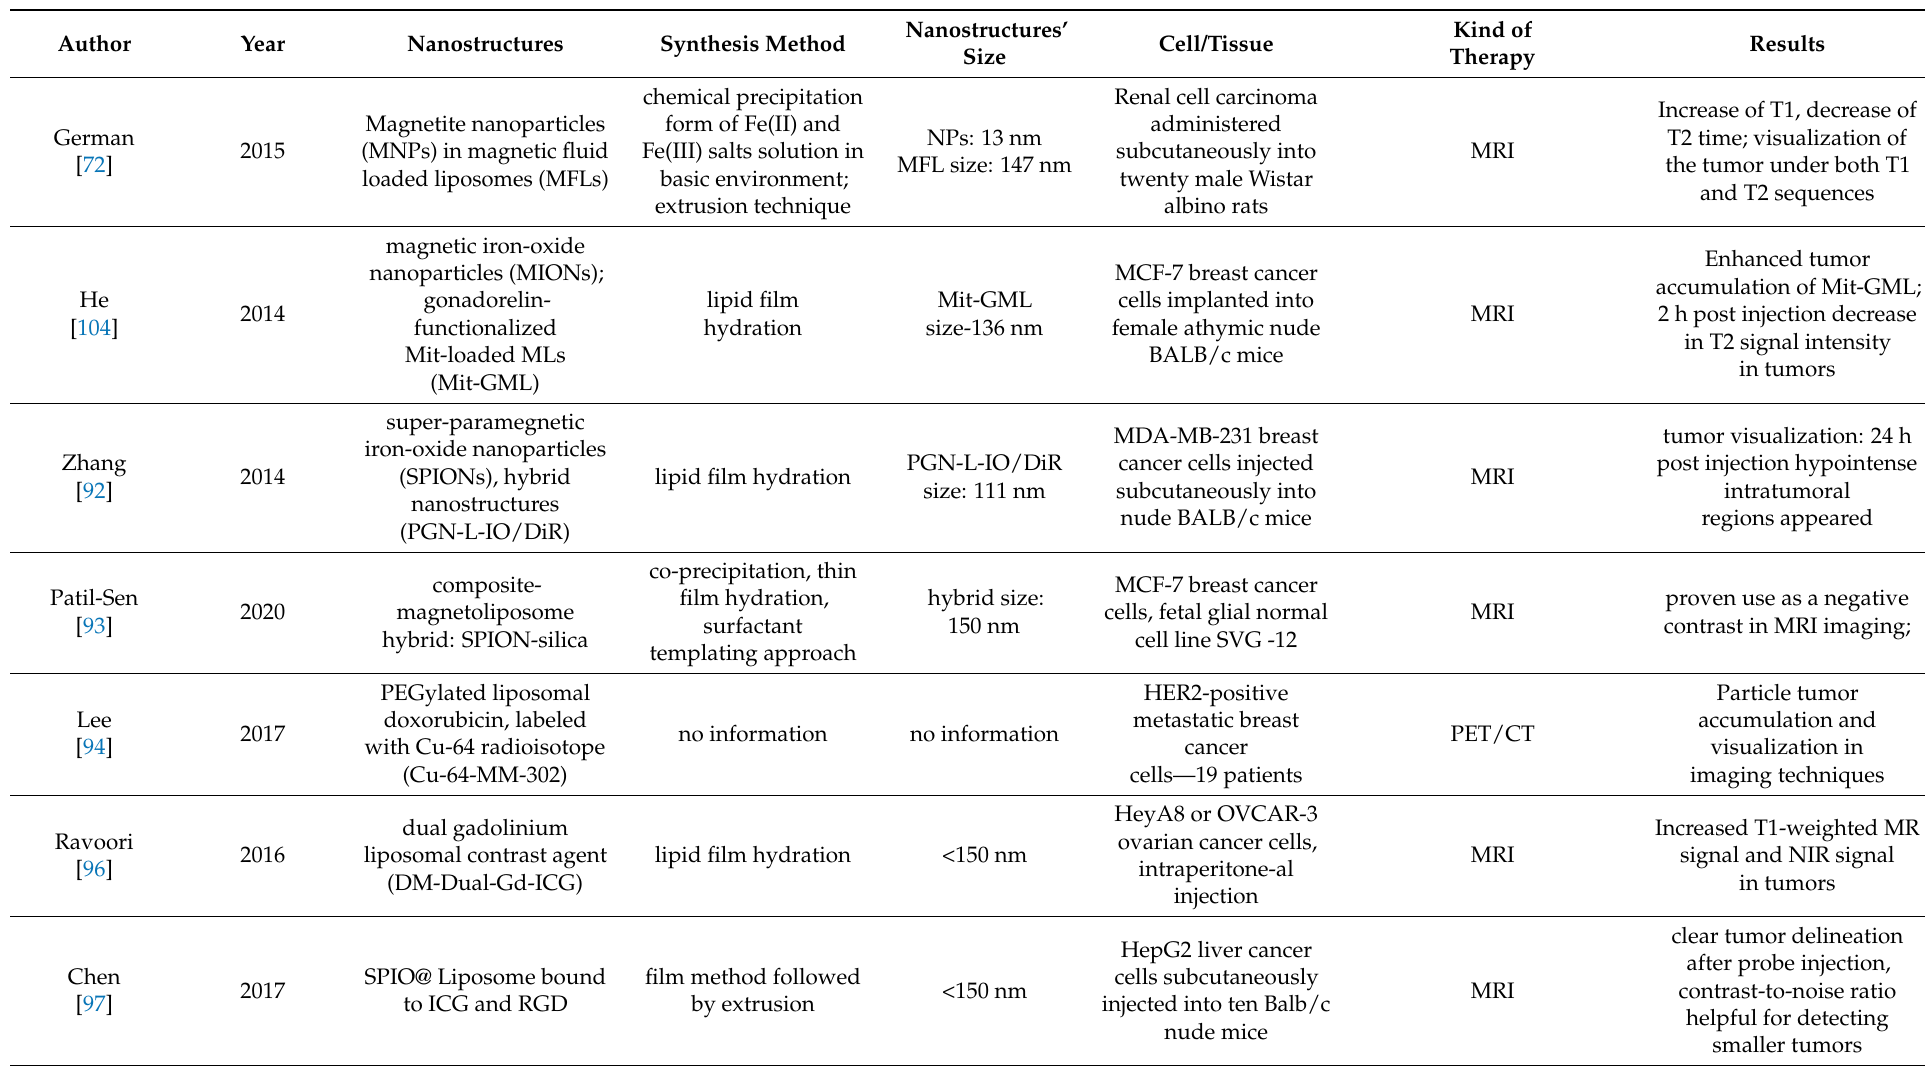
Table 2. Selected applications of liposomes with metallic nanoparticles in medical